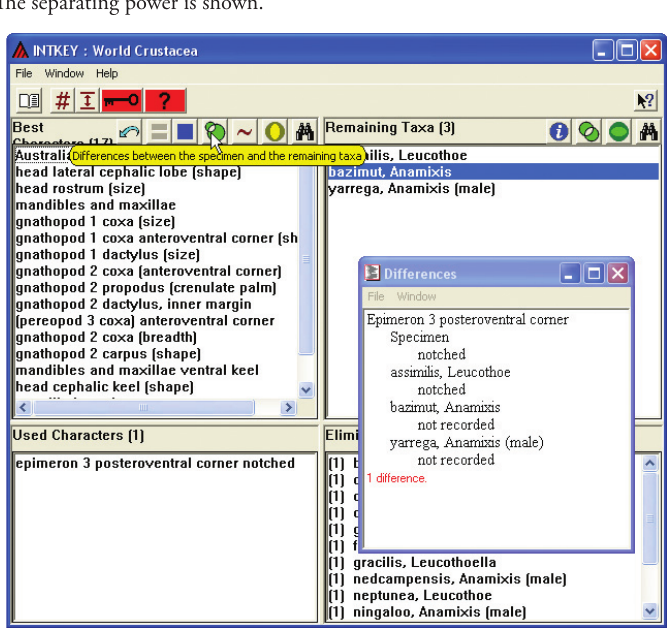
Figure 47. Diff erences between the specimen and the remaining taxa